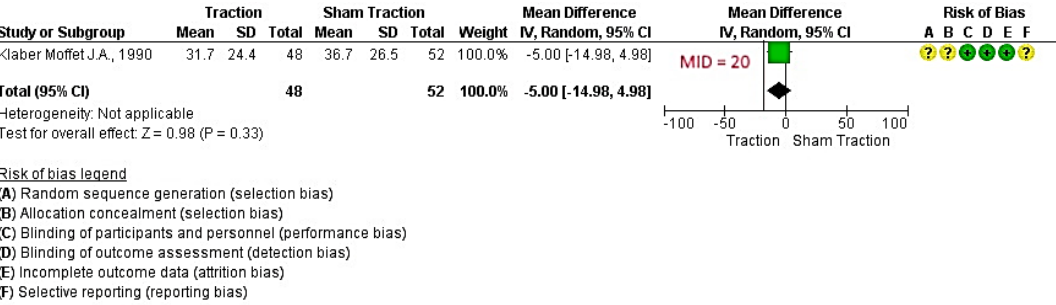
Figure 3. Effect of traction versus sham traction for reducing pain in cervical radicular syndrome. Legend: Red (-) = high risk of bias; Yellow (?) = unknown risk of bias; Green (+) = low risk of bias; MID= Minimal important difference; IV= Inverse of Variance method.